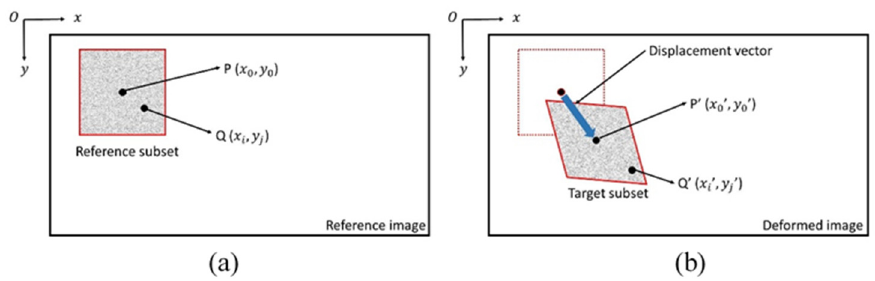
Figure 1. Schematic diagram of object positions ( a ) the position before deformation; ( b ) the position after deformation [18,25].